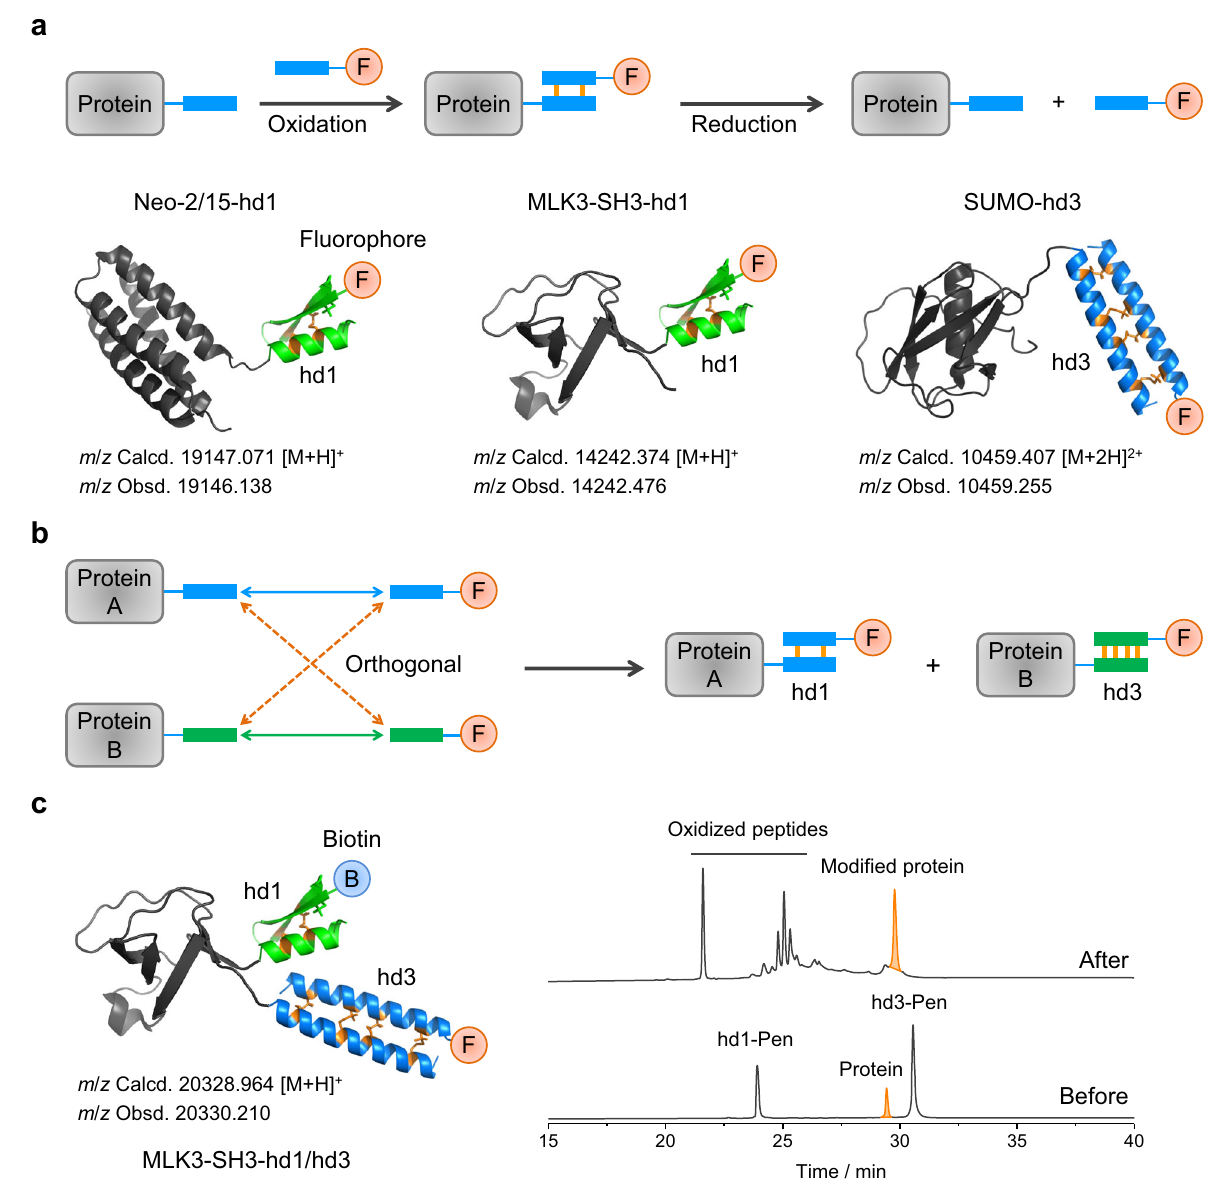
Fig. 5 Potential applications of peptide heterodimerizations. a Labeling of proteins (Neo-2/15, MLK3-SH3, and SUMO; Supplementary Table 6) with functional molecules (e.g., fl uorescent probes) through the heterodimerization. b Schematic illustration of the labeling of two different proteins simultaneously through orthogonal peptide heterodimerizations (HPLC chromatograms showing the formation of the relevant labeled proteins were given in Supplementary Figs. 43 and 44). c Double labeling of a protein through two orthogonal peptide heterodimerizations, and HPLC chromatograms showing the formation of the modi fi ed protein (MLK3-SH3-hd1/hd3; Supplementary Fig. 45). hd1-Pen and hd3-Pen represent the biotin-conjugated Pen-bearing monomer of hd1 and the fl uorescein-conjugated Pen-bearing monomer of hd3, respectively. Other peaks besides the modi fi ed protein come from oxidation of the excess Pen-bearing peptides. Source data are provided as a Source Data fi